Question: What form of chart is displayed?
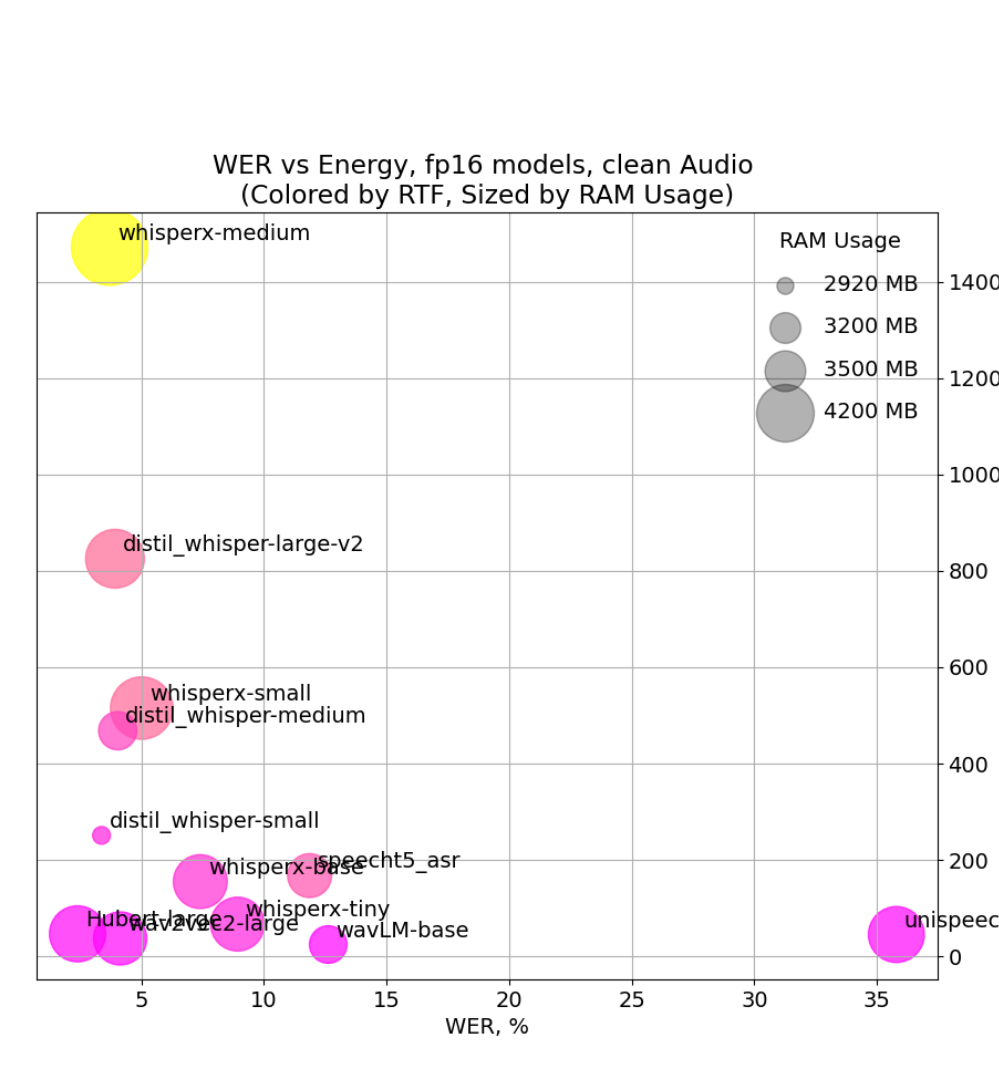
Answer: scatter